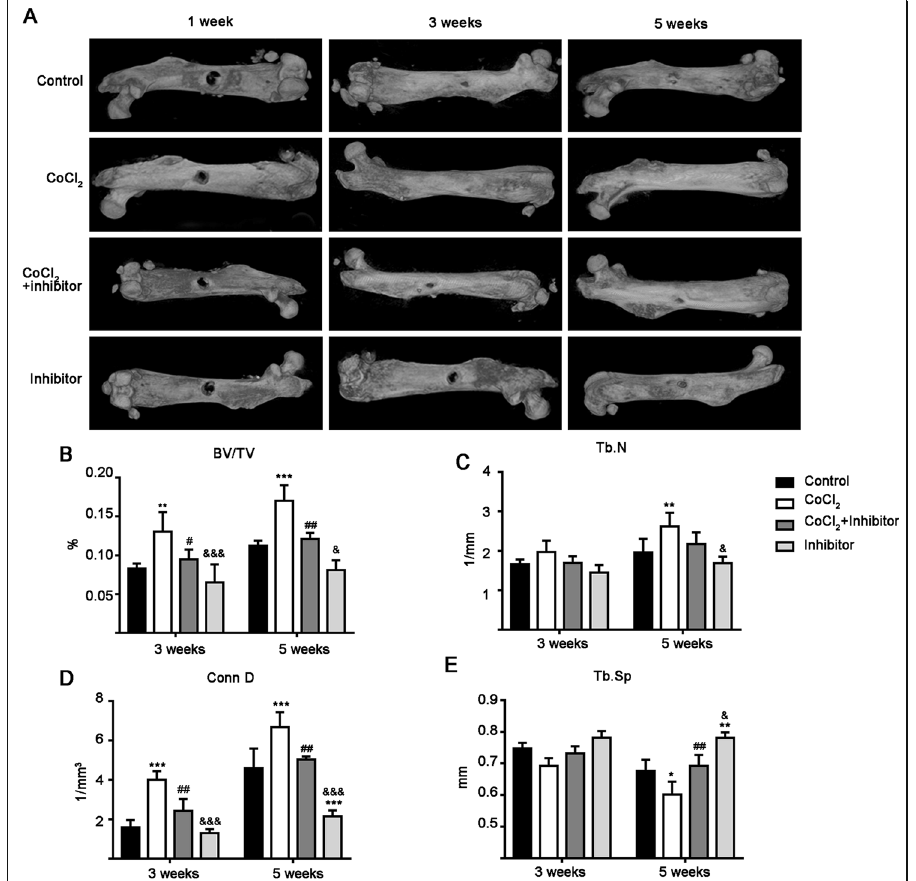
Fig. 6 Images and trabecular parameters for bone defects. a Representative μ -CT images of mouse femurs with bone defects. b - e Quantitative analysis of bone trabecular parameters in the bone defect area. Data of quantitative analysis are the means ± SD from 5 independent experiments, n = 5. Significant effect of the treatment compared to the control group: * p < 0.05, ** p < 0.01 and *** p < 0.001; the CoCl 2 group: # p < 0.05 and ## p < 0.01; and the CoCl 2 + inhibitor group: & p < 0.05 and &&& p < 0.001. Inhibitor: STAT3